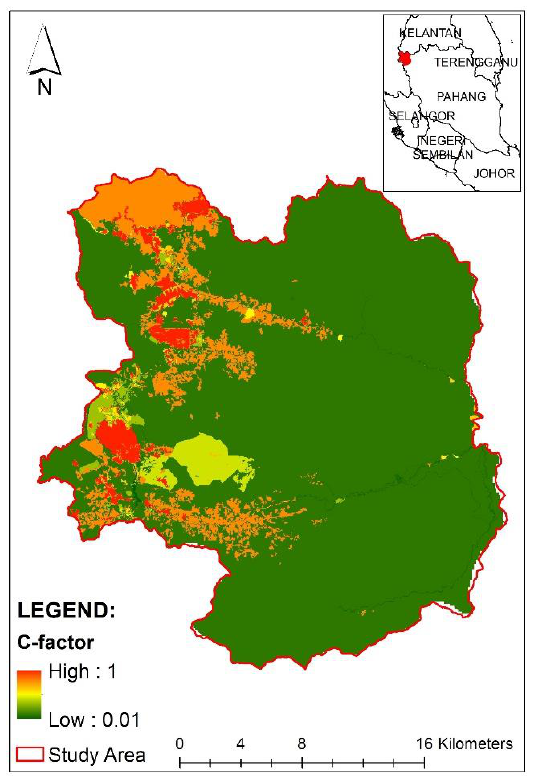
Figure 5. New C factor in Cameron Highlands district [21,22].